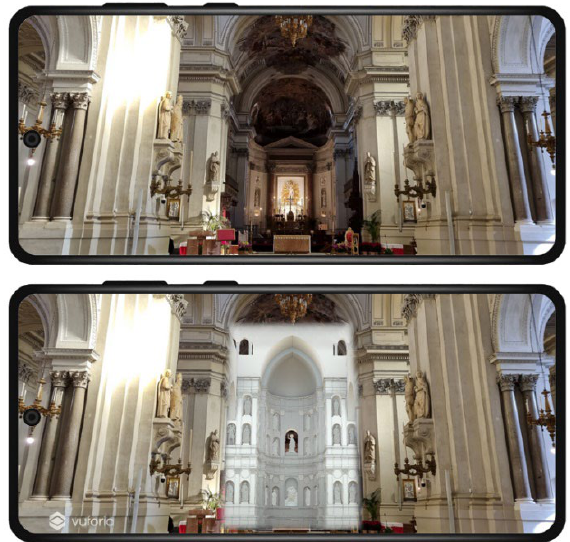
Figure 13. AR visualization of the Tribuna from the nave of the Cathedral with Vuforia’s Area Target